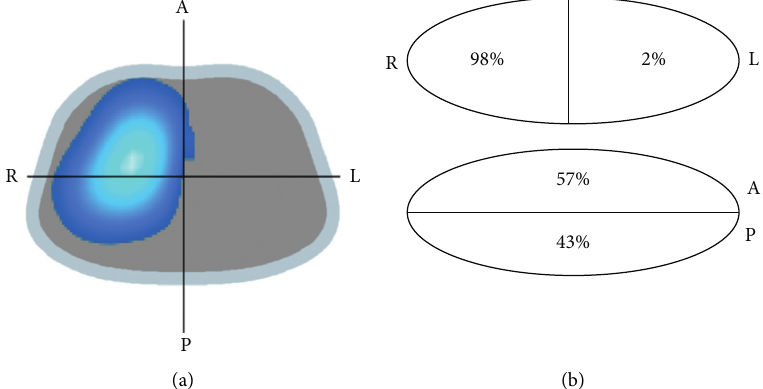
Figure 2: (a) EIT ventilation map for the patient showing right lung ventilation and (b) the EIT ventilation distribution showing 98% of ventilation occurring on the right lung. Figure axes include anterior lung fields (A), posterior lung fields (P), right lung (R), and left lung